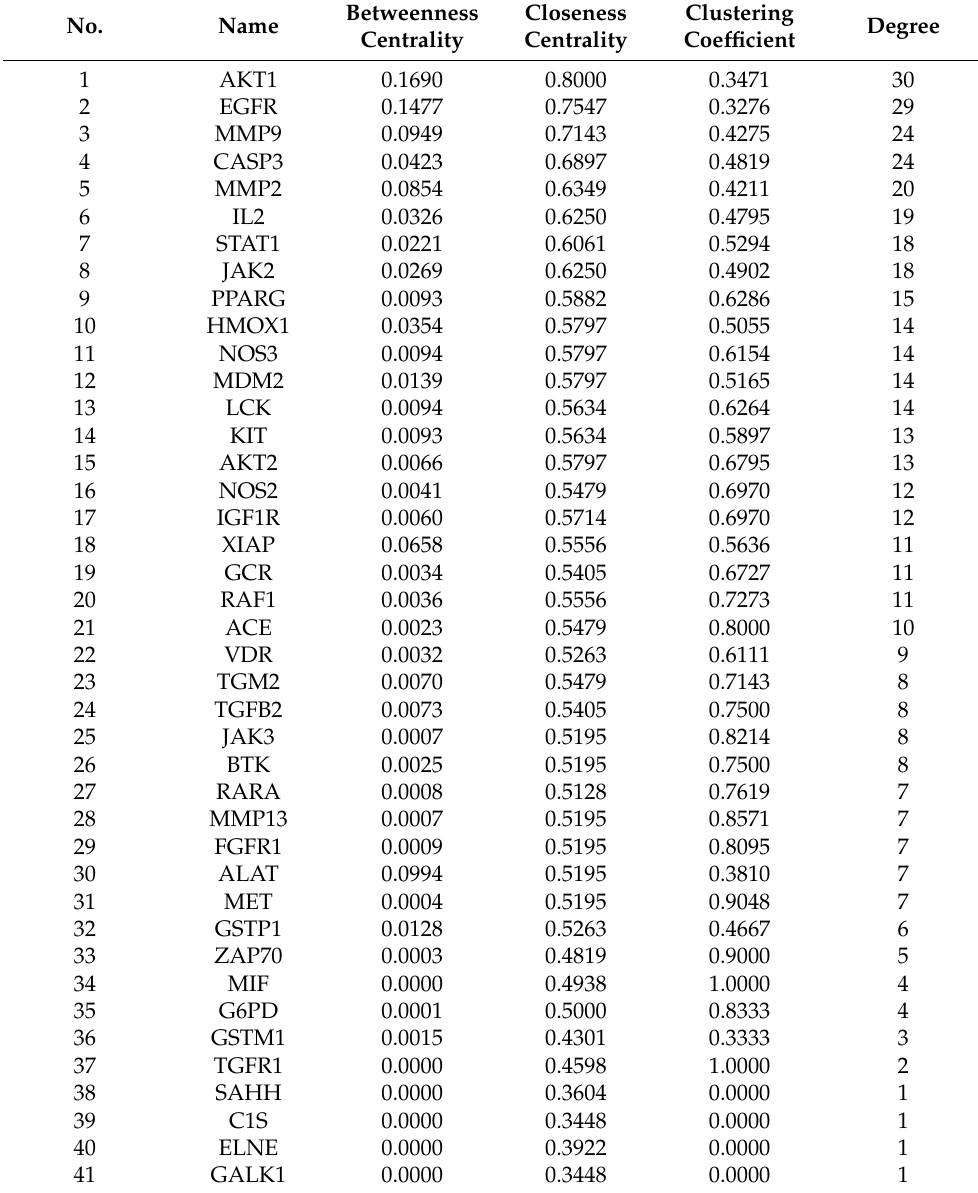
Table 2. Topology analysis of the hub targets protein-protein